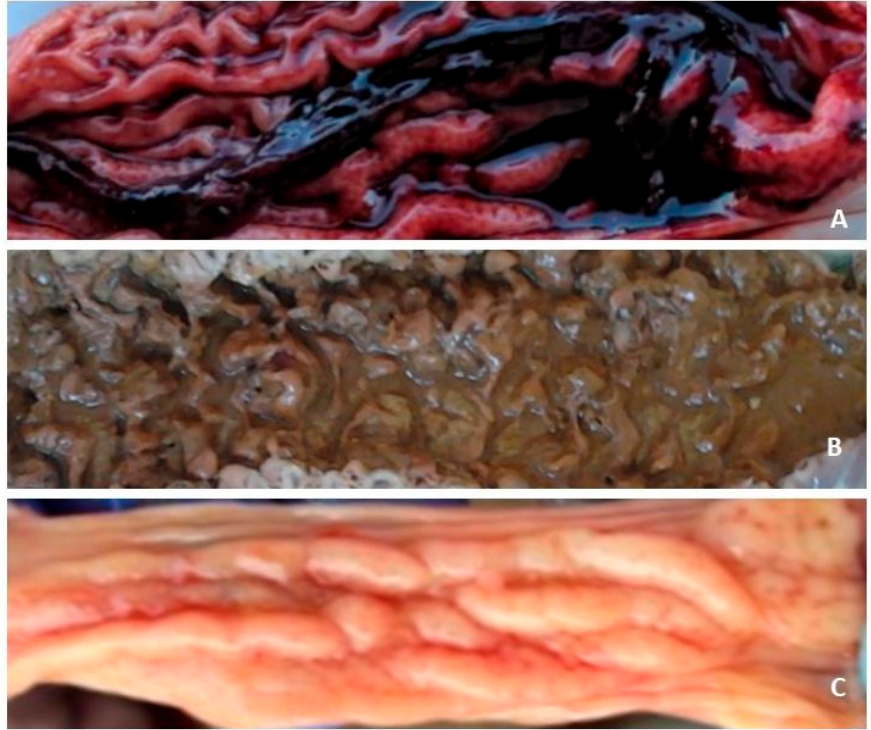
Figure 1. ( A ) Ileum, gross lesion from a clinical case of proliferative haemorrhagic enteropathy (PHE) showing mucosal thickening and reddening associated with luminal blood clots. Out of four cases conferred with anamnesis of acute PE, two, available also as macro photos, confirmed this pattern histologically, while the other two (available only as fixed samples) showed necrotic enteritis (NE), as shown in ( B ). ( C ) From the ileum, a gross lesion of a sample from a pig with chronic diarrhoea, showing mucosal